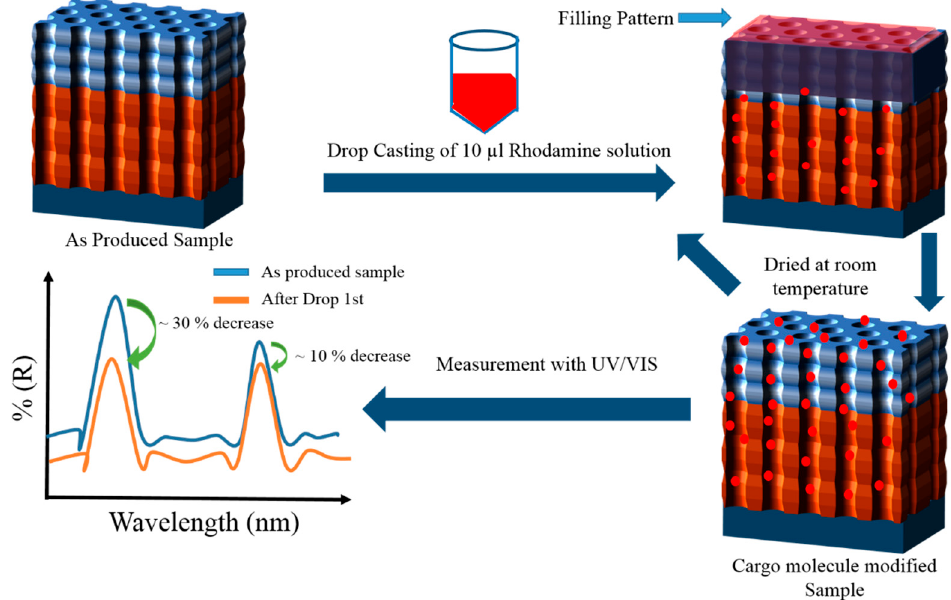
Figure 3. Illustration of drop/dry method performed by drop-casting (10 µL) of Rh6G on the surface of NAA-GIFs followed by the drying procedure in the air and measurement with UV-VIS Spectroscopy. This procedure was repeated for 6 drop/dry cycles for the optical characterization of NAA-GIFs.